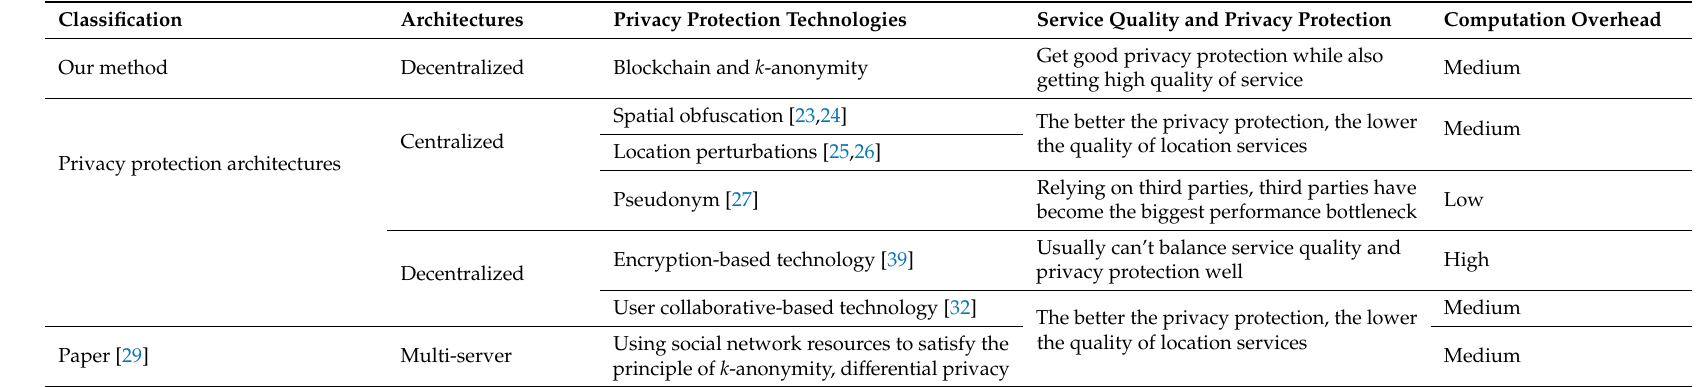
Table 3. Comparison of